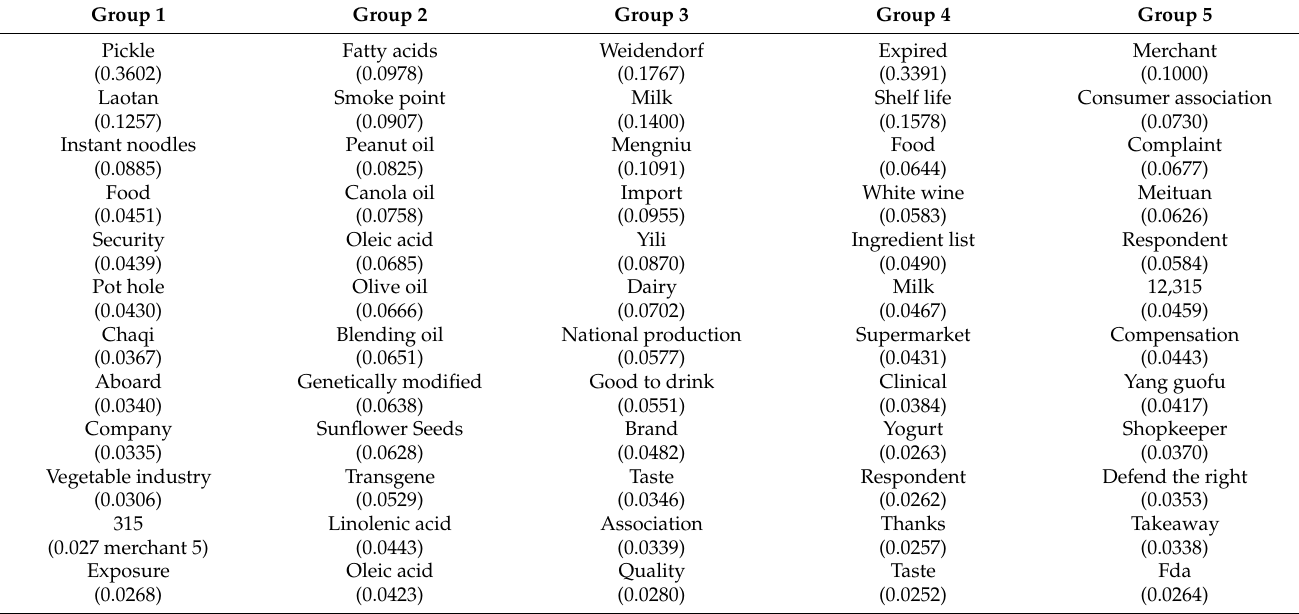
Table 5. Keywords and their weights based on the TF-IDF